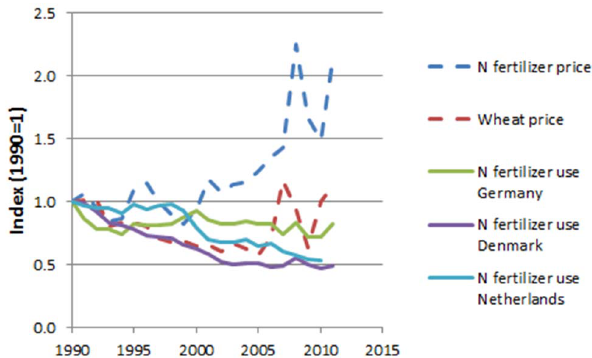
Fig. 9. Trends since 1990 of prices of nitrogen fertilizer and of Figure 9. Trends since 1990 of prices of nitrogen fertilizer and of wheat in the EU, and trends 2 wheat in the EU, and trends of total use of inorganic nitrogen fer- of total use of inorganic nitrogen fertilizer in agriculture in Germany (http://www.bmelv- 3 tilizer in agriculture in Germany (http://www.bmelv-statistik.de; N statistik.de; N fertilizer use in 1990 was 130 kgN/ha), Denmark (http://www.statbank.dk/; N 4 fertilizer use in 1990 was 130kgNha − 1 ), Denmark (http://www. fertilizer use in 1990 was 150 kgN/ha) and The Netherlands (http://statline.cbs.nl/StatWeb/; 5 statbank.dk/; N fertilizer use in 1990 was 150kgNha − 1 ) and the N fertilizer use in 1990 was 220 kgN/ha) (downloaded October 31, 2012). 6 Netherlands ( http://statline.cbs.nl/StatWeb/; N fertilizer use in 1990 was 220kgNha − 1 ) (downloaded 31 October 2012). Note: the Mac- Note: The MacSharry reform in 1992 and later reforms reduced the price support for cereals 7 Sharry reform in 1992 and later reforms reduced the price support and therefore also the price of wheat. 8 for cereals and therefore also the price of